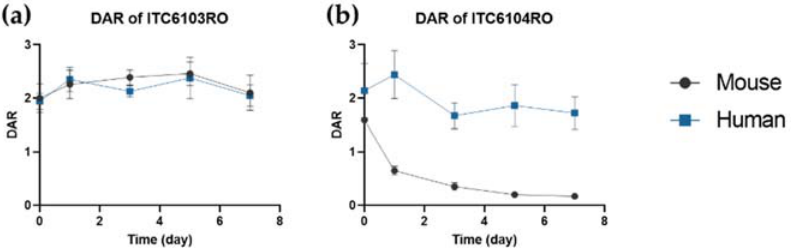
Figure 3. The drug–antibody ratio (DAR) profiles from in vitro linker stability in mouse and